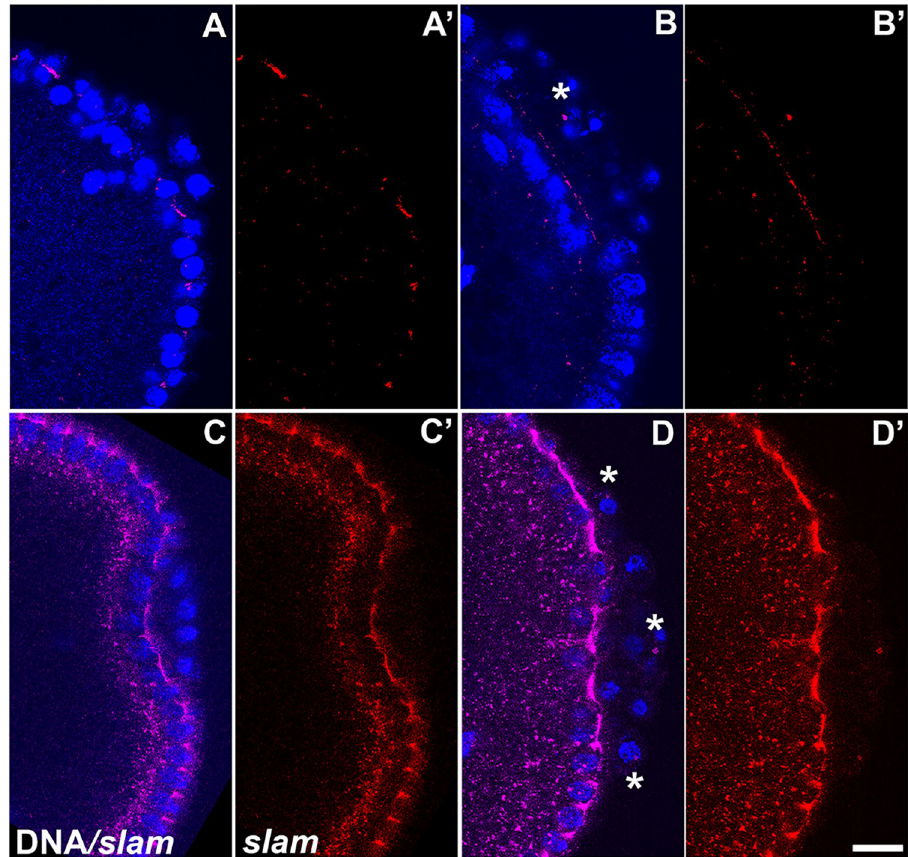
Fig 5. PGCs from dpp -compromised embryos display ectopic expression of the somatic cellularization gene slow as molasses ( slam ) in PGCs. smFISH was performed using probes specific for slam (red) on (A/C) egfpi , (B) dpp hr92 , and (D) dppi 33618 embryos. Nuclei were labeled using Hoescht (blue). Asterisks highlight PGC nuclei in dpp - compromised embryos expressing slam RNA. Scale bar represents 10 μ